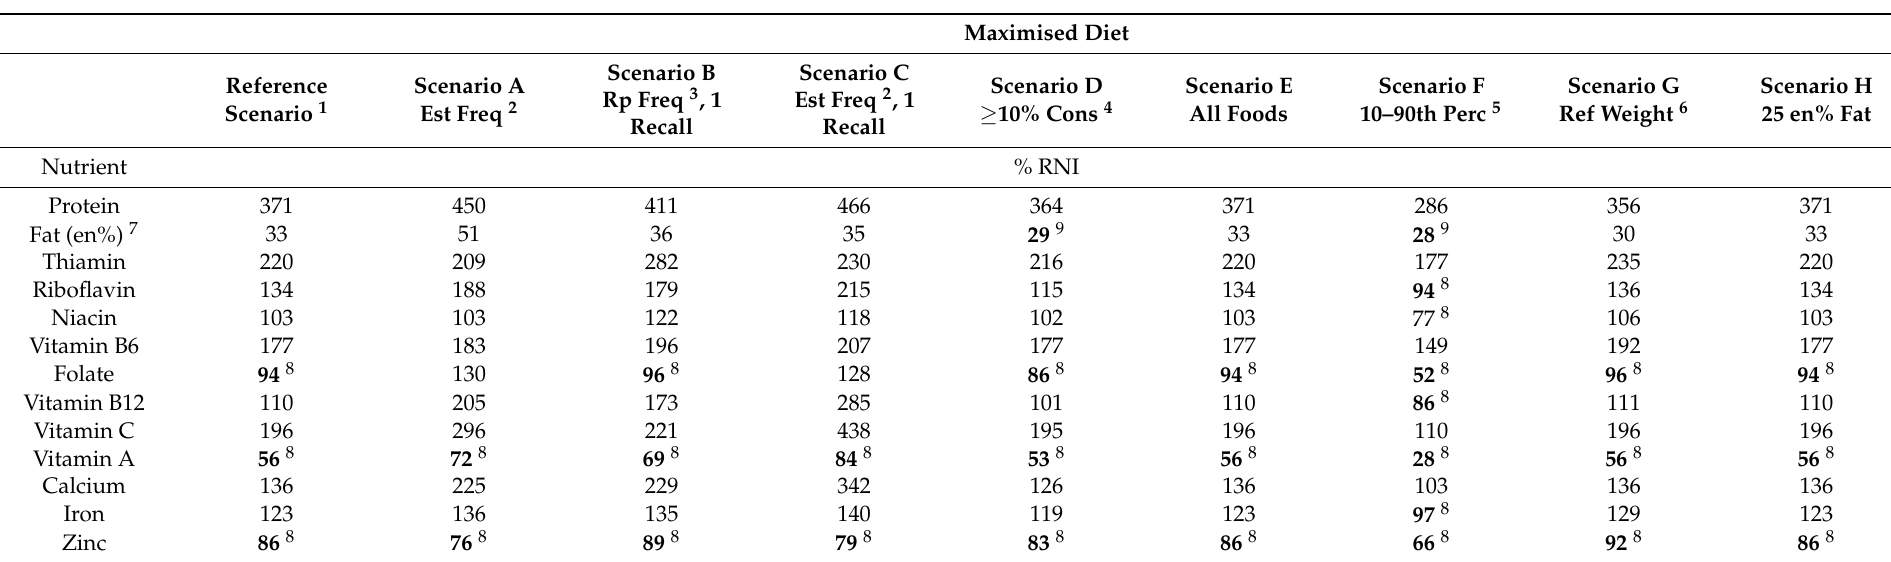
Table 4. Identified problem nutrients as % of RNI in a maximised diet per nutrient for reference scenario and alternative scenarios for Kenyan children, 4–6 years of